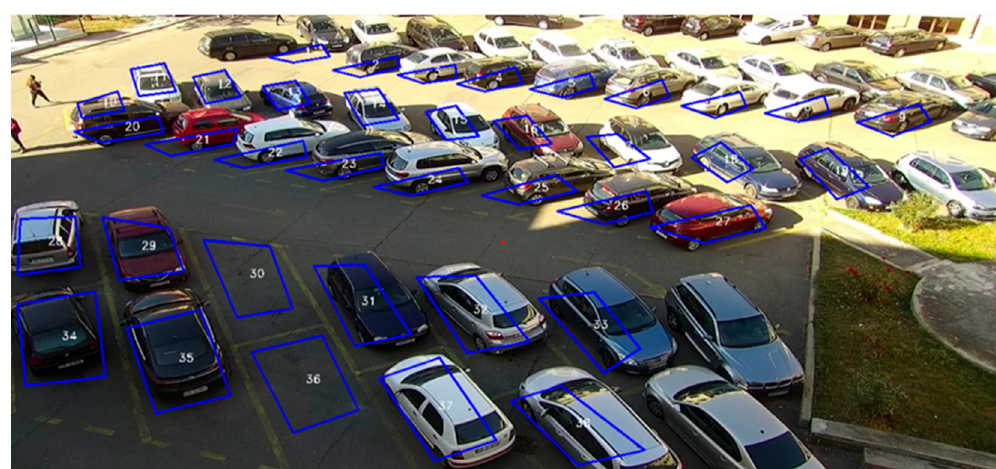
Figure 3. Defined parking area map on benchmark 2.